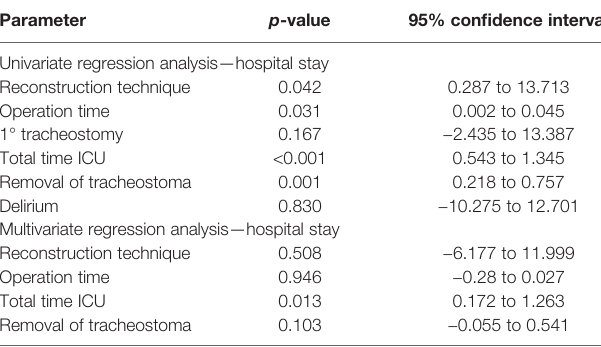
TABLE 6 | Uni- and multivariate regression analyses of possible confounders on hospital stay.